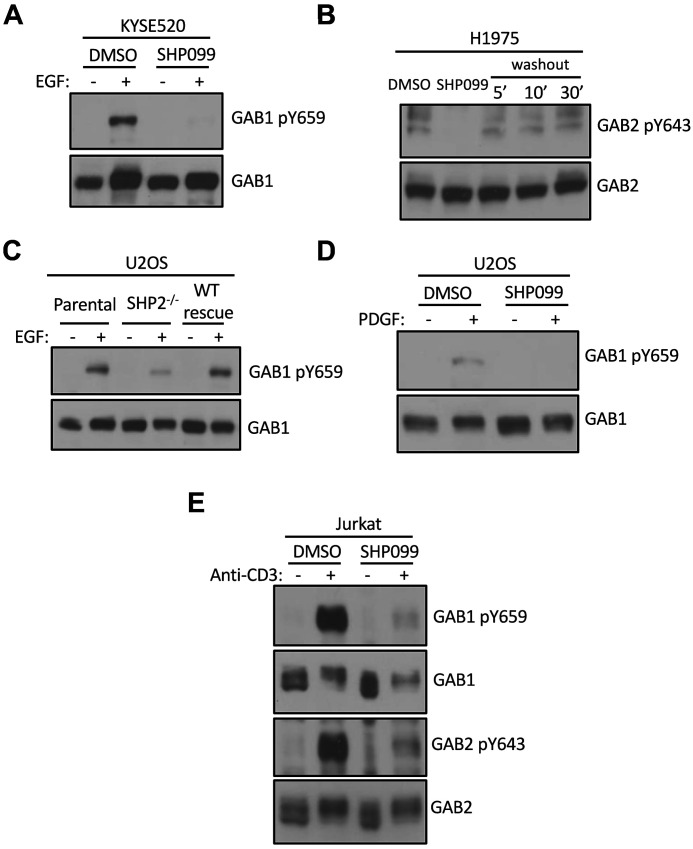
SHP2 regulates GAB1 and GAB2 phosphorylation in multiple cellular contexts.(A) KYSE520 cells pre-treated with DMSO carrier or SHP099 (10 uM) for 2 hr were left uninduced or induced with EGF (10 nM) for 10 min. Whole-cell lysates were then subjected to immunoblotting with GAB1-pY659 and GAB1 antibodies. (B) H1975 cells were treated with SHP099 (10 uM) for 2 hr, washed three times with warm HBSS buffer, and cultured in full growth medium (RPMI-1640 supplemented with 10% FBS) for the indicated time periods. Lysates were then blotted with pY643-GAB2 and GAB2 antibodies. (C) Whole-cell extracts from parental-, SHP2 knockout-, and SHP2 knockout stably expressing wild-type SHP2 U2OS cell lines were blotted with pY659-GAB1 and GAB1 antibodies. (D) DMSO- and SHP099-treated U2OS cells were stimulated with PDGF (5 nM) and probed for pY659-GAB1 and GAB1. (E) DMSO- and SHP099-treated Jurkat cells were stimulated with anti-CD3 antibody (10 µg/ml) and subjected to immunoblotting with pY659-GAB1, pY643-GAB2, GAB1, and GAB2 antibodies. Western blot results are representative of at least n = 2 independent biological replicates.